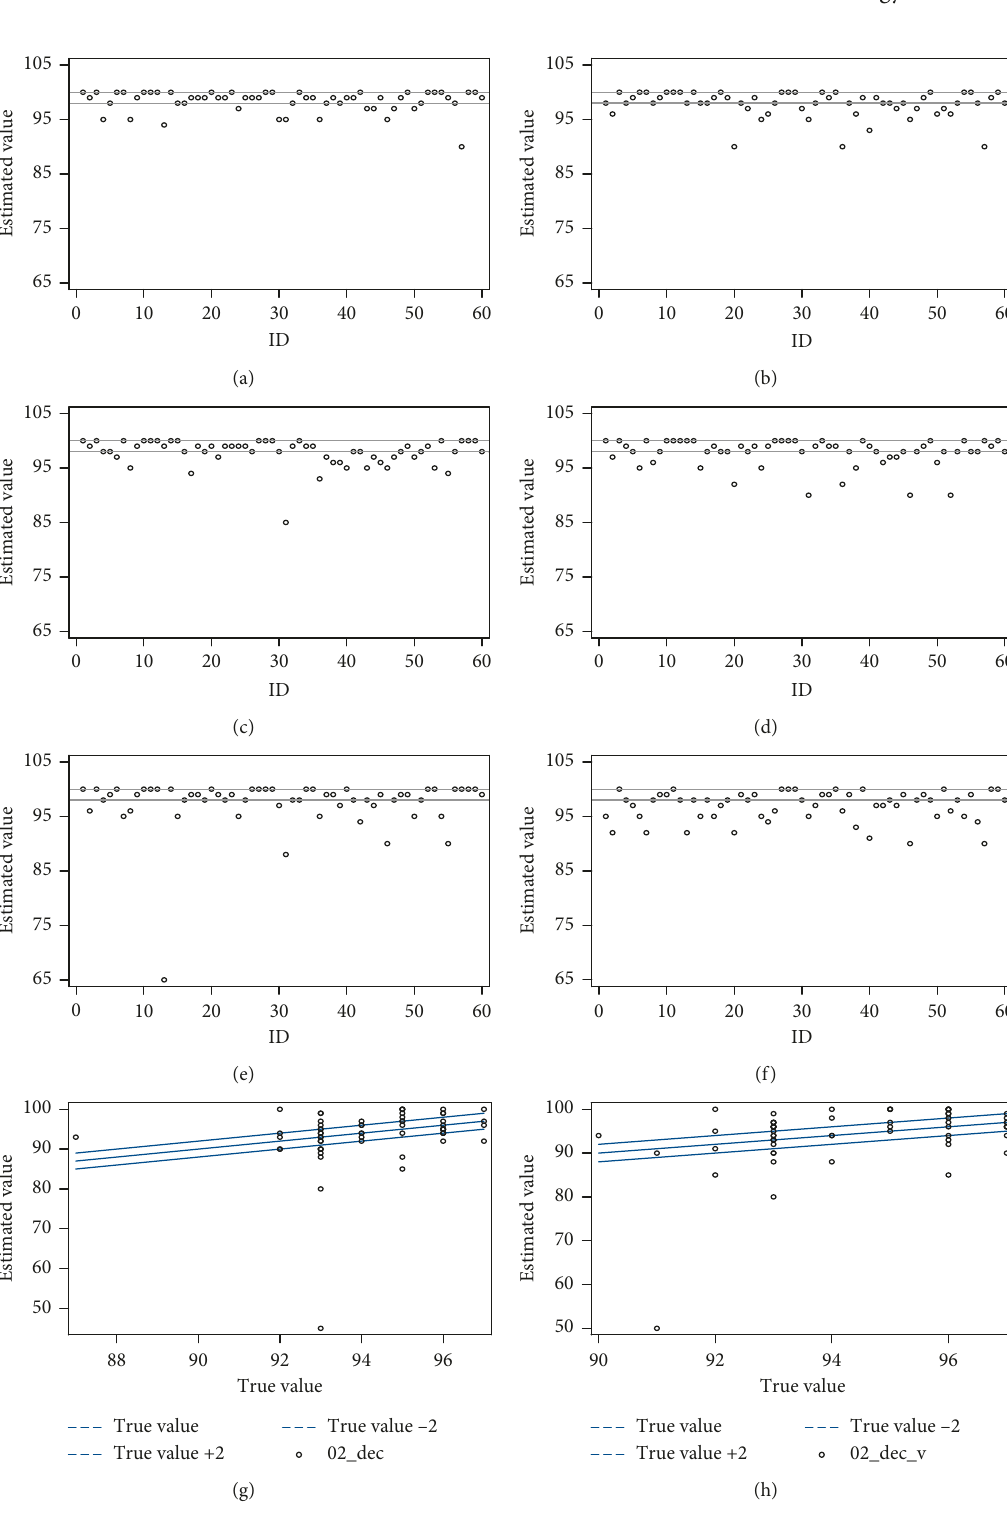
Figure 2: Oxygen saturation estimation under different recording settings. Each dot represents one individual estimation, and the lines represent thetrue values and theacceptable correct estimating values(true value 2). (a)Scenario A first attempt. (b) Scenario C firstattempt. (c)Scenario B after A. (d) Scenario B after C. (e) Scenario A second attempt. (f) Scenario C second attempt. (g) Scenario D after A. (h) Scenario D after ±